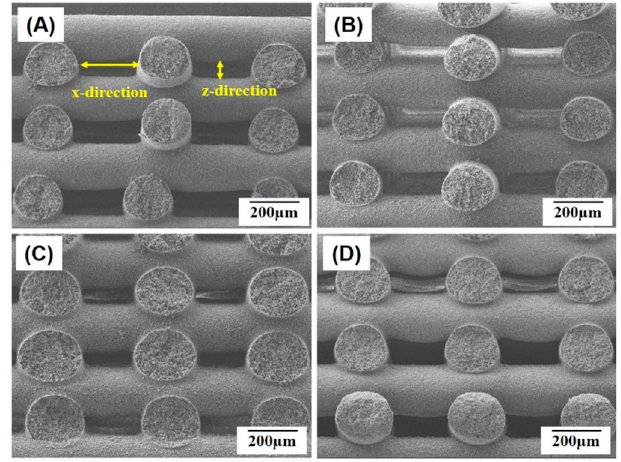
Figure 3. Representative FE-SEM images of the macro/micro-porous PCL/HA composite scaffolds produced with various HA contents of ( A ) 0 wt %; ( B ) 10 wt %; ( C ) 15 wt %; and ( D ) 20 wt %, showing the cross-sectional morphology.